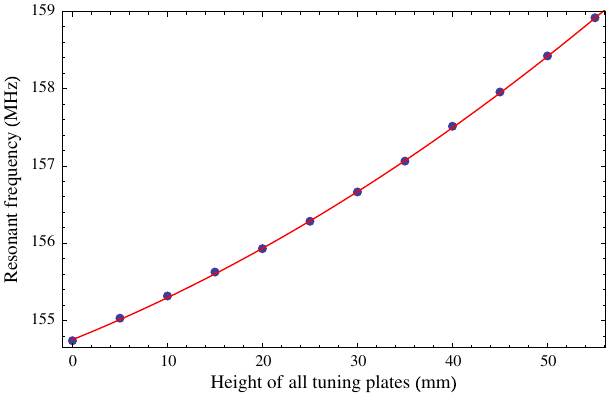
FIG. 10 (color online). The resonant frequency when all the tuning plates are raised to the same height calculated by MWS. When all the tuning plates are at 0 mm, the resonant frequency is 154.7 and 158.4 MHz at 50 mm. The red curve is a quadratic fit to the data.